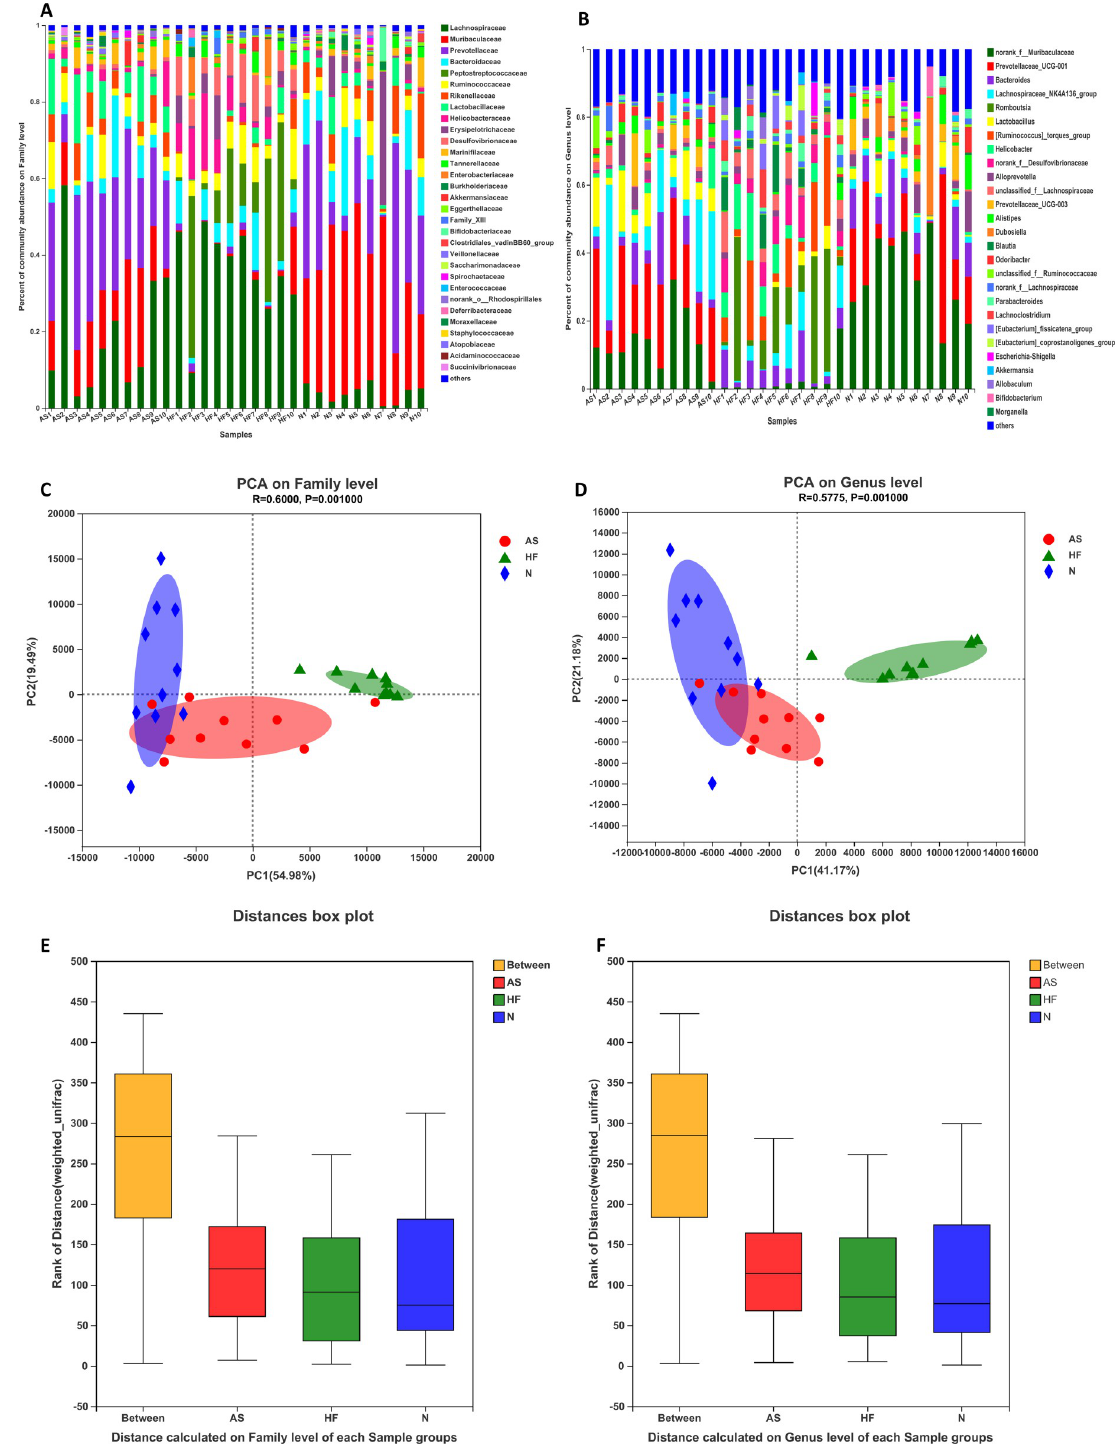
Fig 2. Fecal microbial composition analysis and beta-diversity analysis. A, B: analysis of the fecal microbial composition of the three groups on the family level and genus level; B, C: PCA analysis is used to explore the correlation of the composition of the microbiome on the family level and genus level of each group; C, D: ANOSIM analysis compares differences between groups and within groups (C:P < 0.001, D: P < 0.001).